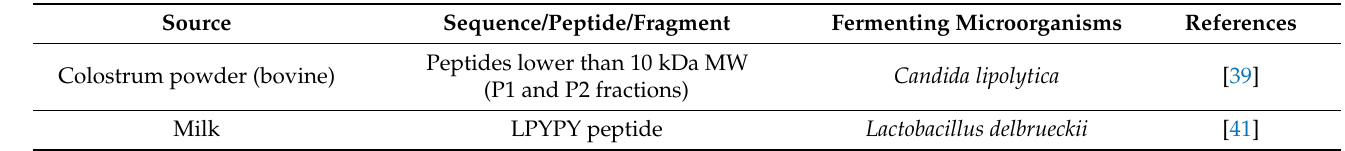
Figure 1. Production of milk-derived BAPs and their possible therapeutic potentials. Table 3. Milk-derived peptides produced using